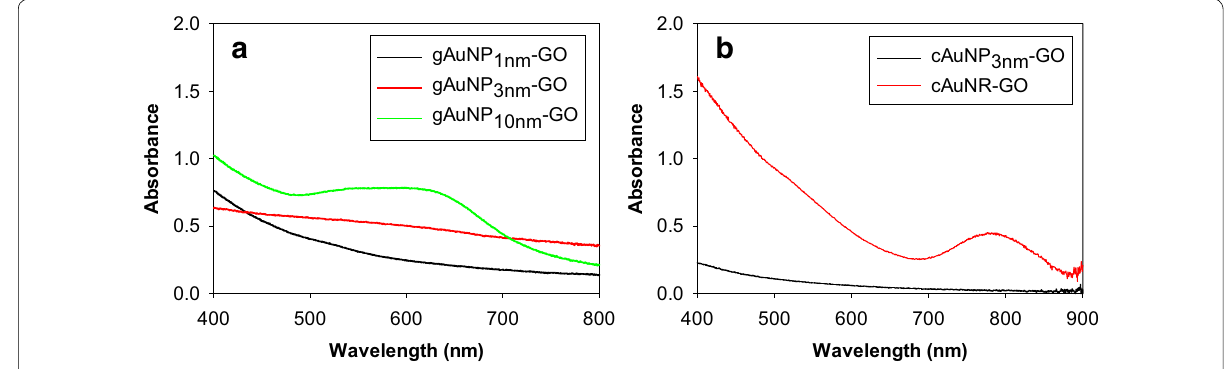
Fig. 4 UV‑vis spectra of a gAuNP 10nm ‑GO, gAuNP 3nm ‑GO, and gAuNP 1nm ‑GO and b cAuNP 3nm ‑GO and